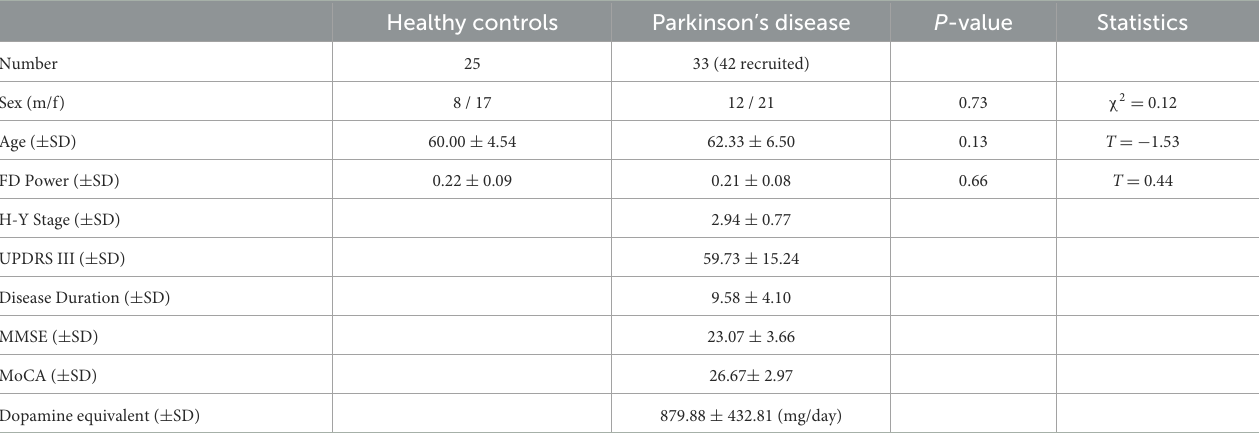
TABLE 1 Demographic information of